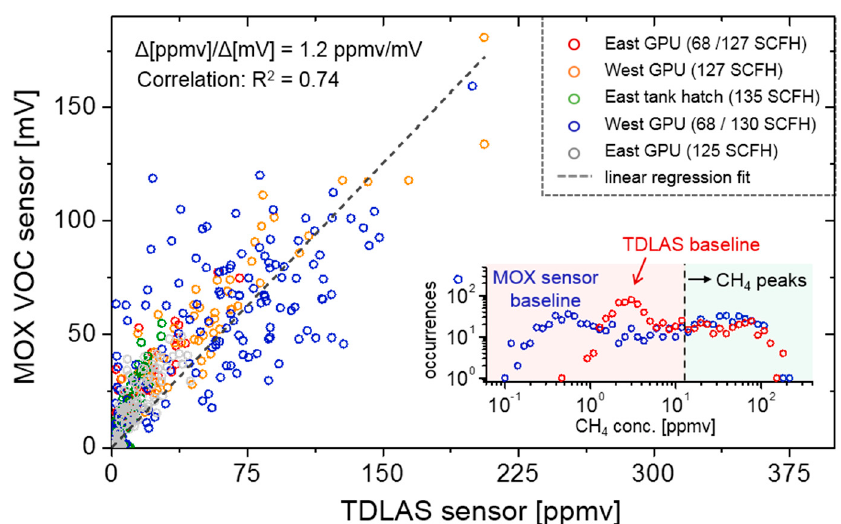
Figure 7. Correlation between TDLAS sensor readings and a proximally located MOX sensor during the 5 control leak measurements at varying locations and leak rates. The data spans a total of 4.4 h with 20 s integration time per point, yielding a scaling factor of 1.2 ppmv / mV. The inset shows a scatter histogram plot, indicating the distribution of baseline noise dominates CH 4 measurements below 12 ppmv and defines the threshold for peak discrimination.